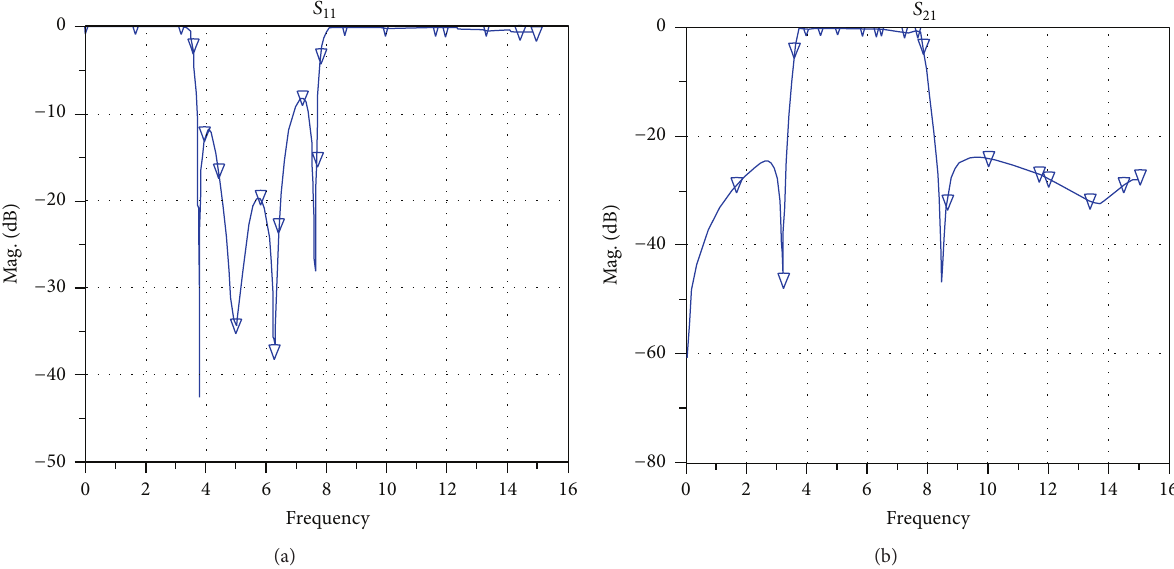
Figure 9: Simulated frequency response of the broadband band-pass filter designed using a MMR resonator in the workspace of ADS versus return losses (𝑆 11 ) and insertion losses (𝑆 21 )